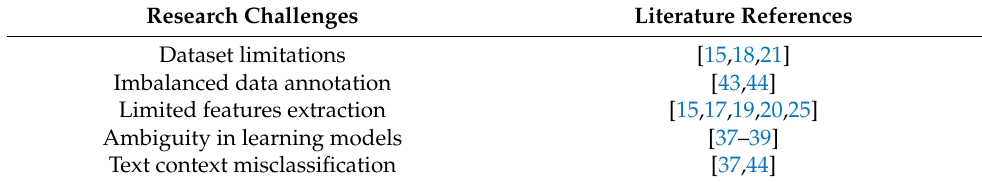
Table 1. Evaluation Table Literature